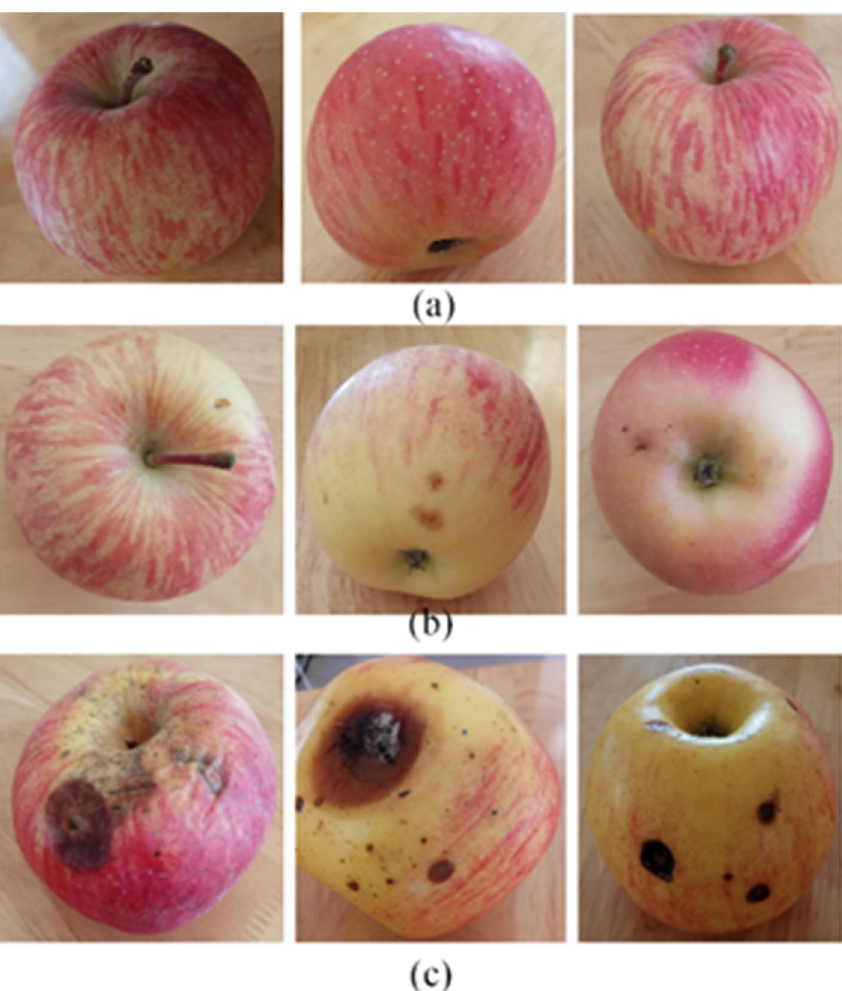
Figure 2. A few of images of premium ( a ), middle ( b ) and poor ( c ) grade